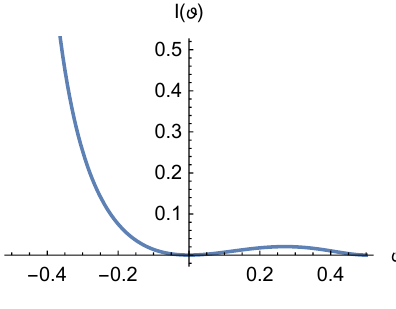
Figure 6 . I ( # ) as a function of #